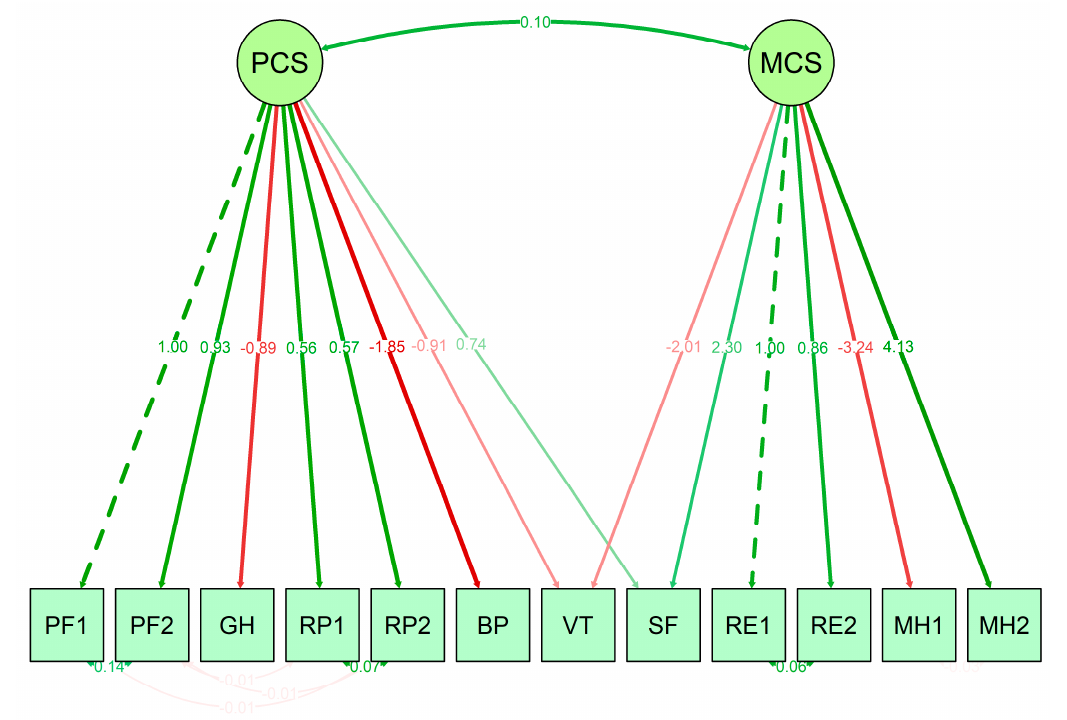
Figure 2. Structure of the SF-12 Scale in the CFA. The values show the coefficients of the model. We name the items according to the dimension of SF-36, PF = Physical Functioning, GH = General Health, RP = Role Physical, BP = Bodily Pain, VT = Vitality, SF = Social Functioning, RE = Role Emotional, MH = Mental Health.